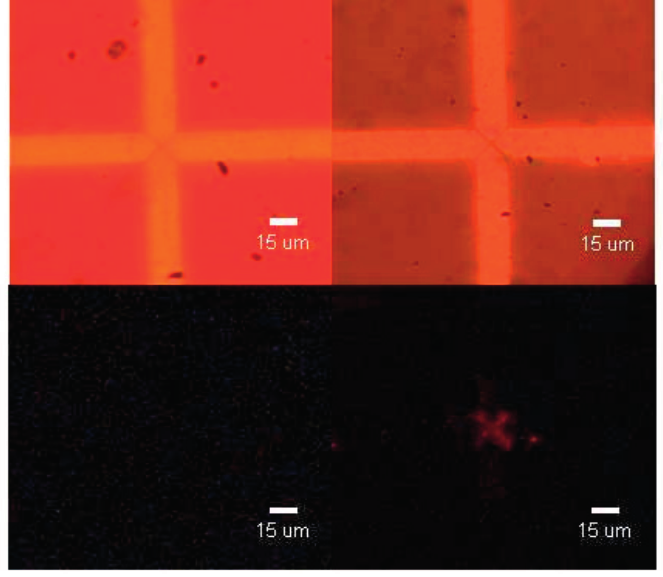
Figure 4. Demonstration of M13 capture using triangular electrodes with a gap spacing of 4 μ m. Left: Visible light ( top ) and UV light ( bottom ) images of anti-fd functionalized electrodes. Right: Visible light ( top ) and UV light ( bottom ) images of anti-fd functionalized electrodes with dielectrophoretically captured M13 phage. Conditions: V pp = 15 V, f = 1 MHz, capture time: 30